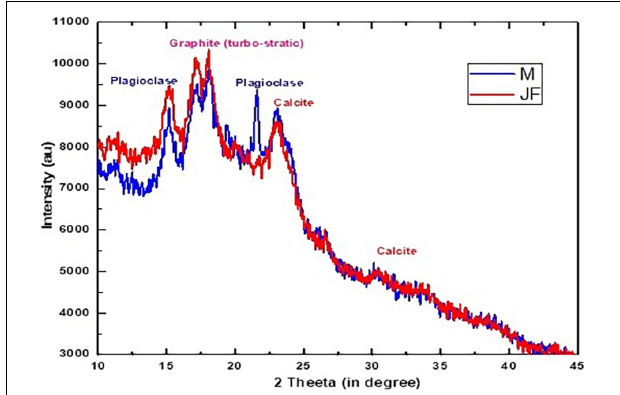
FIGURE 3 | XRD spectra of bio-sorbent material of Mango (MF) and Jack fruit (JF) kernel biomass.